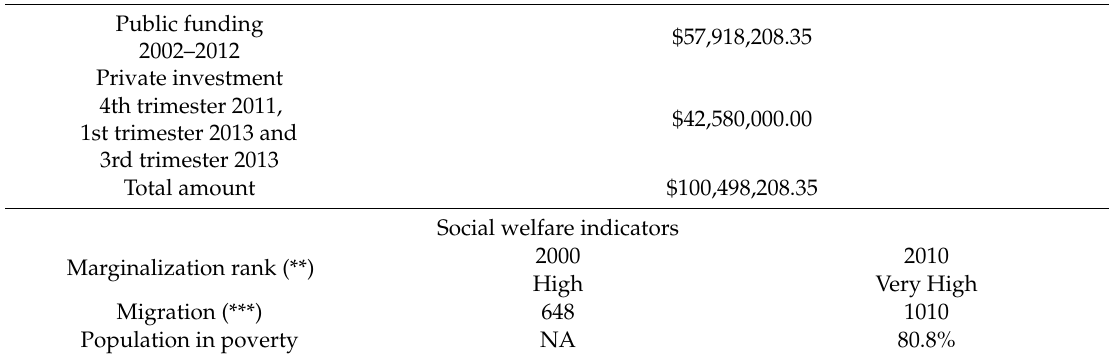
Table 2. Public and private touristic economic investment vs. social welfare in Cuetzalan. Source: Armenta-Ram í rez (2020) based on SECTUR (Secretar í a de Turismo) [42], SNIM (Sistema Nacional de Informaci ó n Municipal) [25] and SEDESOL (Secretar í a de Desarrollo Social) [43]. CONAPO (Consejo Nacional de Poblaci ó